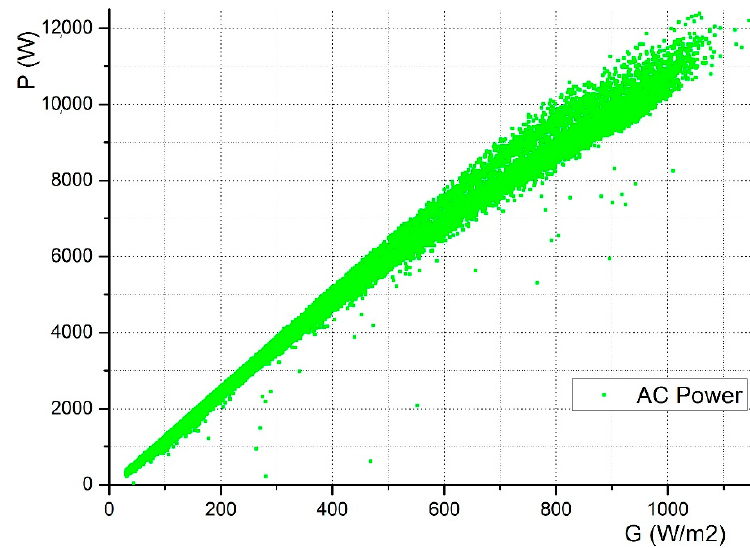
Figure 5. Correlation between irradiance and AC power output.